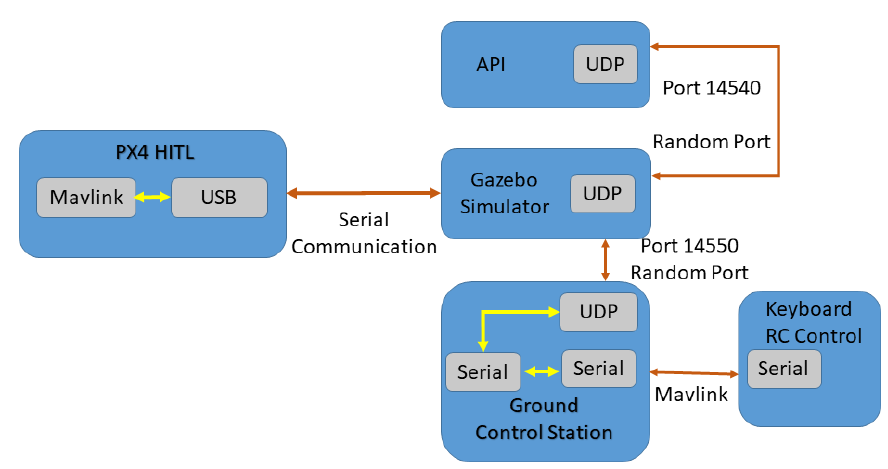
Figure 3. Block diagram of the hardware-in-the-loop simulation environment.